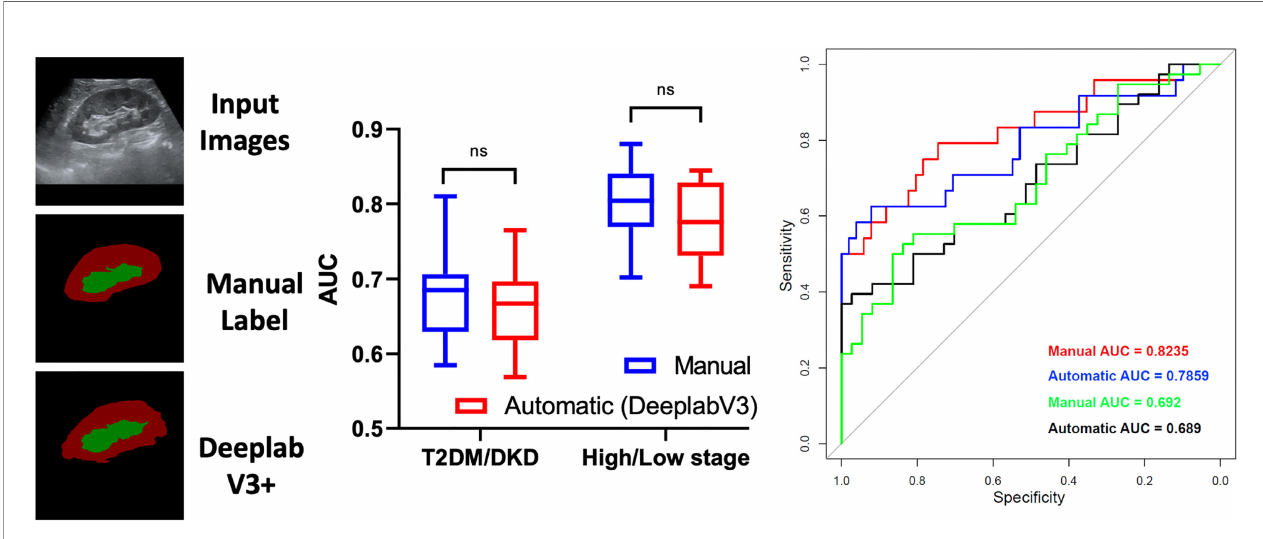
FIGURE 6 | Diagnostic Performance of deep learning-based automatic segmentation, radiomics for diabetic kidney disease. ns, no signi fi